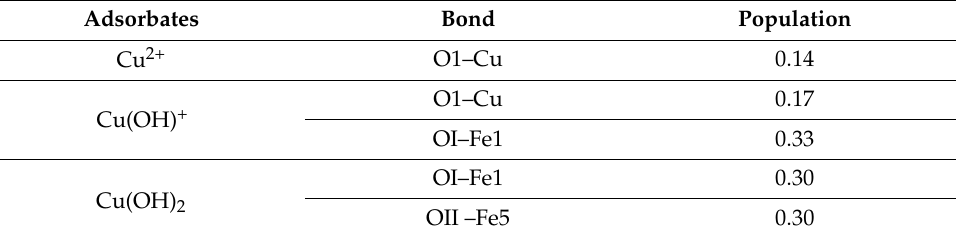
Table 5. Mulliken bond populations of different Cu components adsorbed on the specularite (0 0 1)